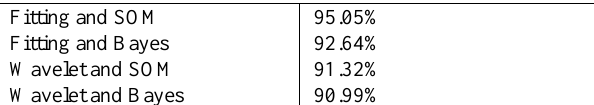
Table 4: Validation